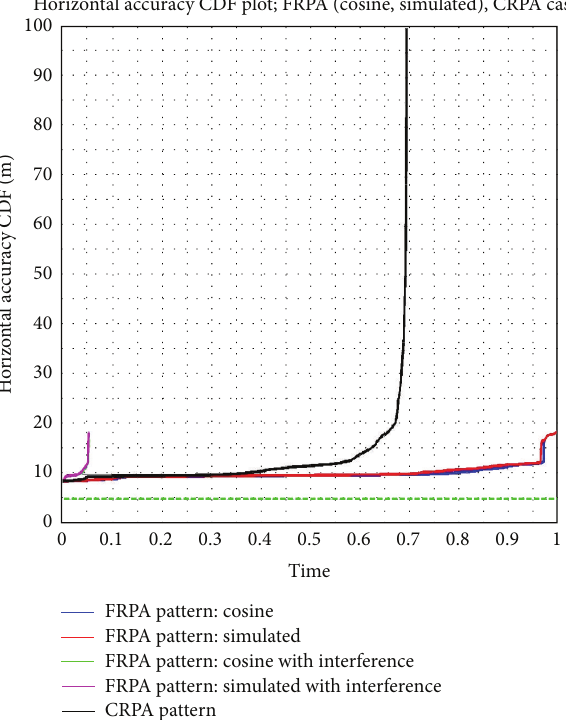
Figure 22: Horizontal accuracy CDF curve − 24/24GPS constella- tion and 5RF interfering satellites.